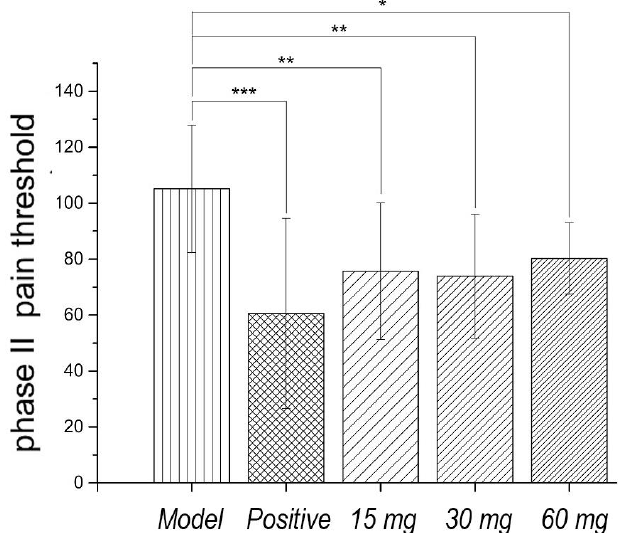
Figure 4. Effect of Gg on phase II pain threshold of rat model induced by Faure Marin. Gg showed